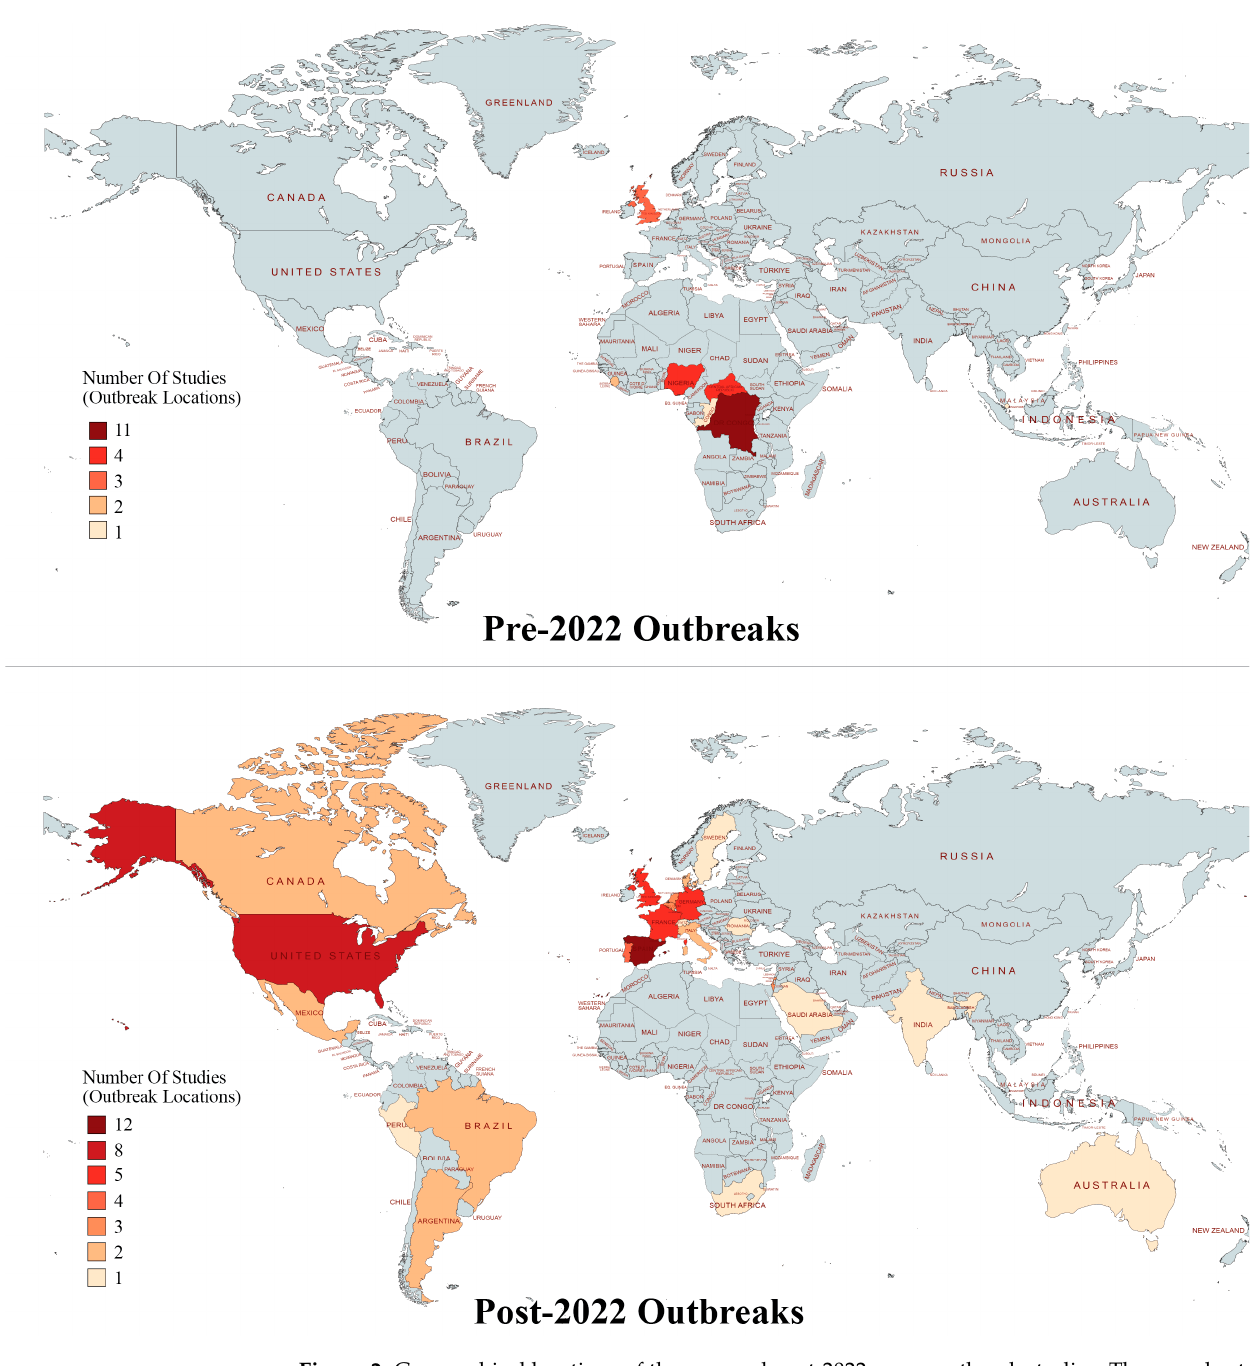
Figure 2. Geographical locations of the pre- and post-2022 mpox outbreak studies. The mapchart.net website was used for drawing the world